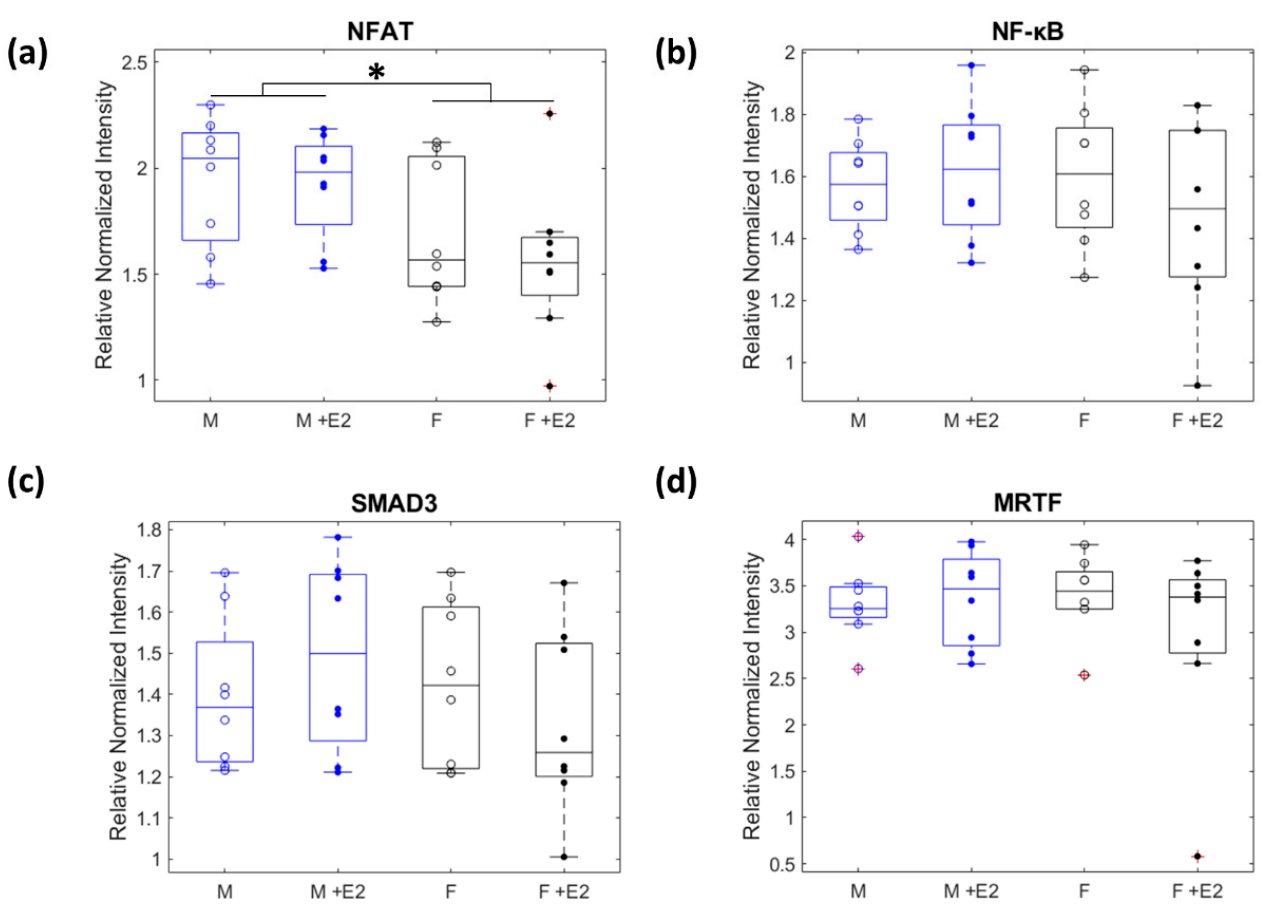
Figure 5. A two-way ANOVA was used to determine if there was any significant interaction ( α = 0.05) between sex (male = blue and female = black) and estrogen treatment (baseline = open dots to represent median of biological replicates and +E2 = closed dots) of translocation of profibrotic proteins to the nucleus. The median nucleus: cytoplasm ratio of NFAT was significantly different due to biological sex (* p < 0.05, ( a )). There were no significant interactions between or within groups for NF- κ B, SMAD3, or MRTF ( b – d ).